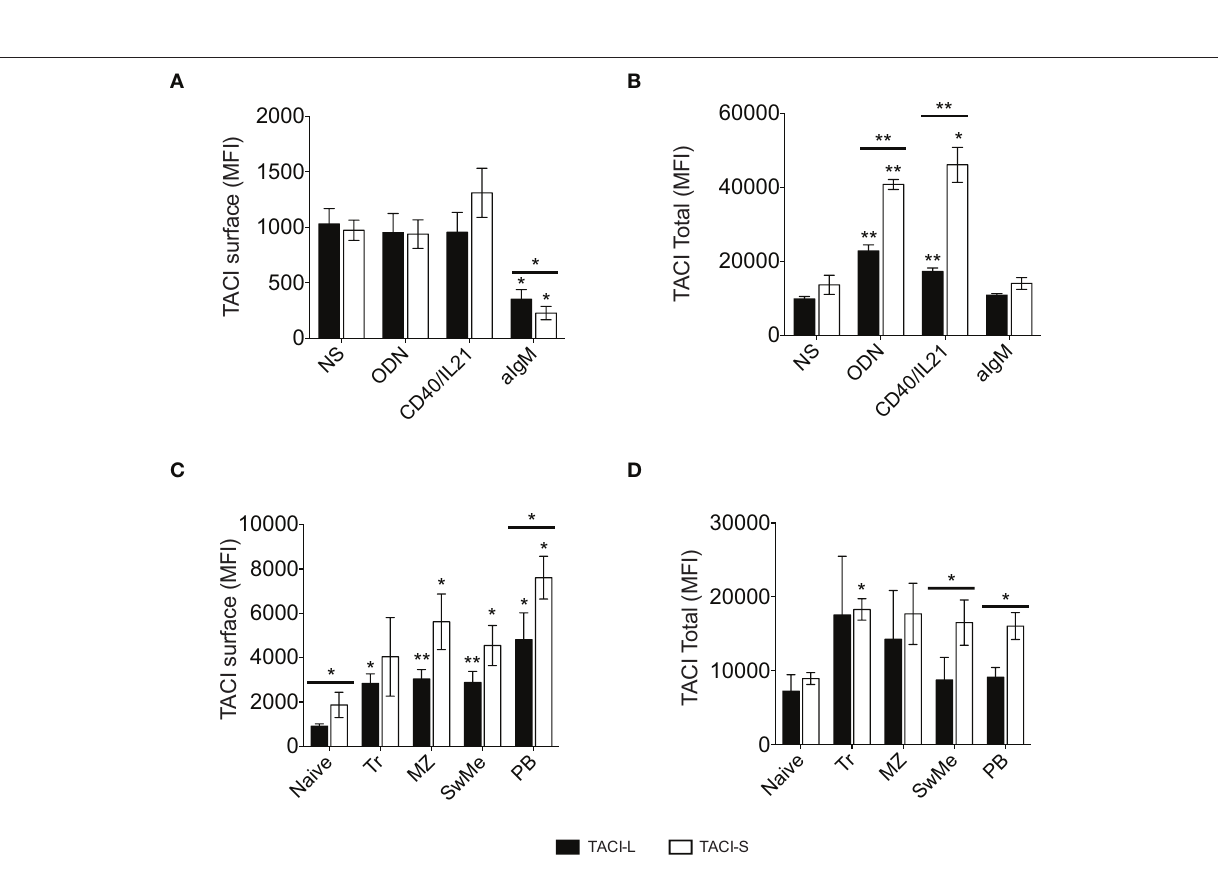
Frontiers in Immunology |